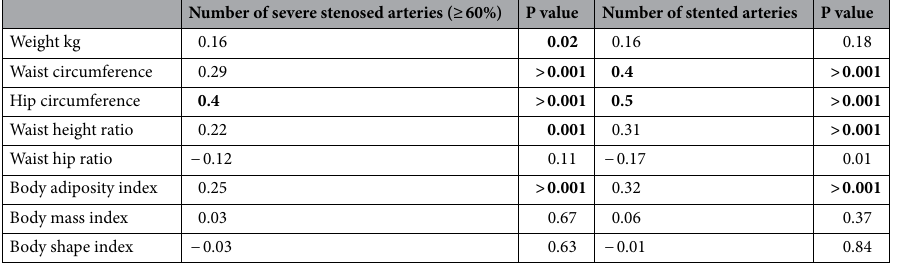
Table 3. Correlations (Pearson) between obesity parameters and number of stenosed coronary arteries (≥ 60%) and number of stented coronary arteries ( N = 220). Significant values are in bold.